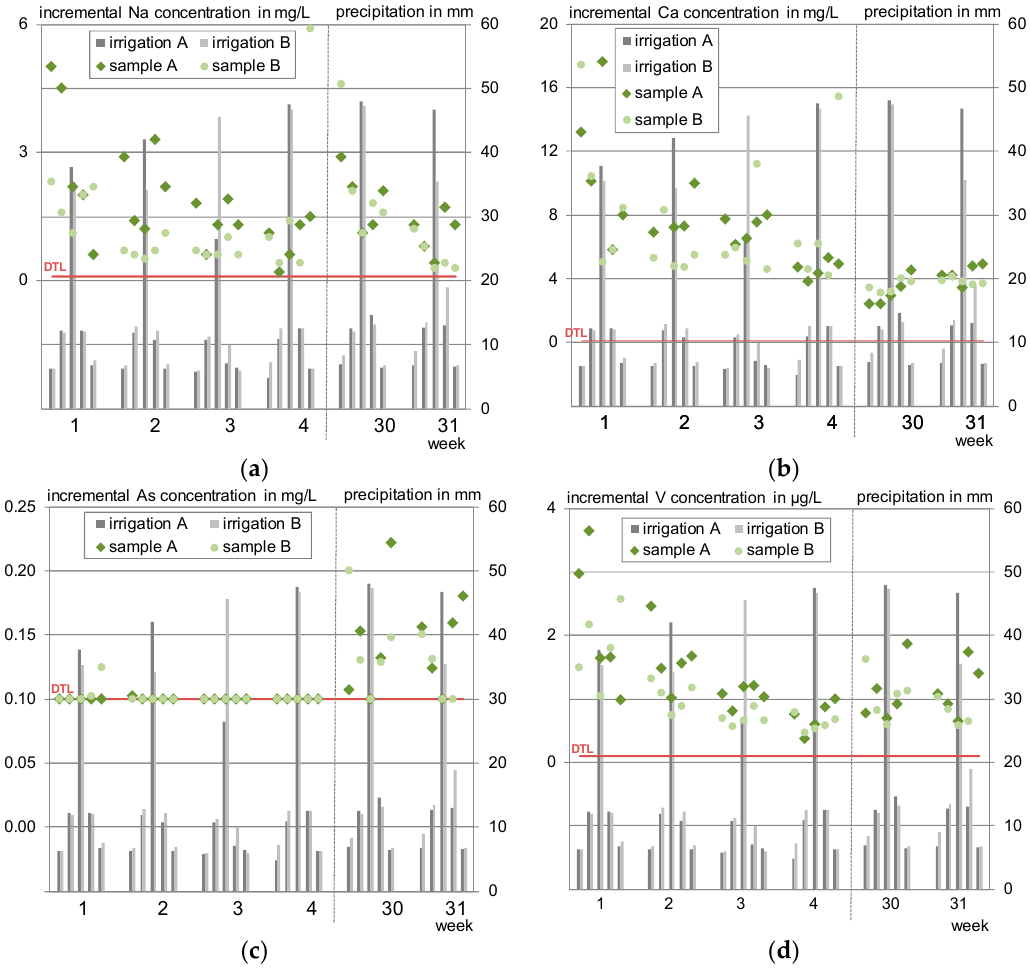
Figure 16. Incremental eluate concentrations of the test specimens L 1-2. ( a ) sodium; ( b ) calcium; ( c ) arsenic; ( d ) vanadium.